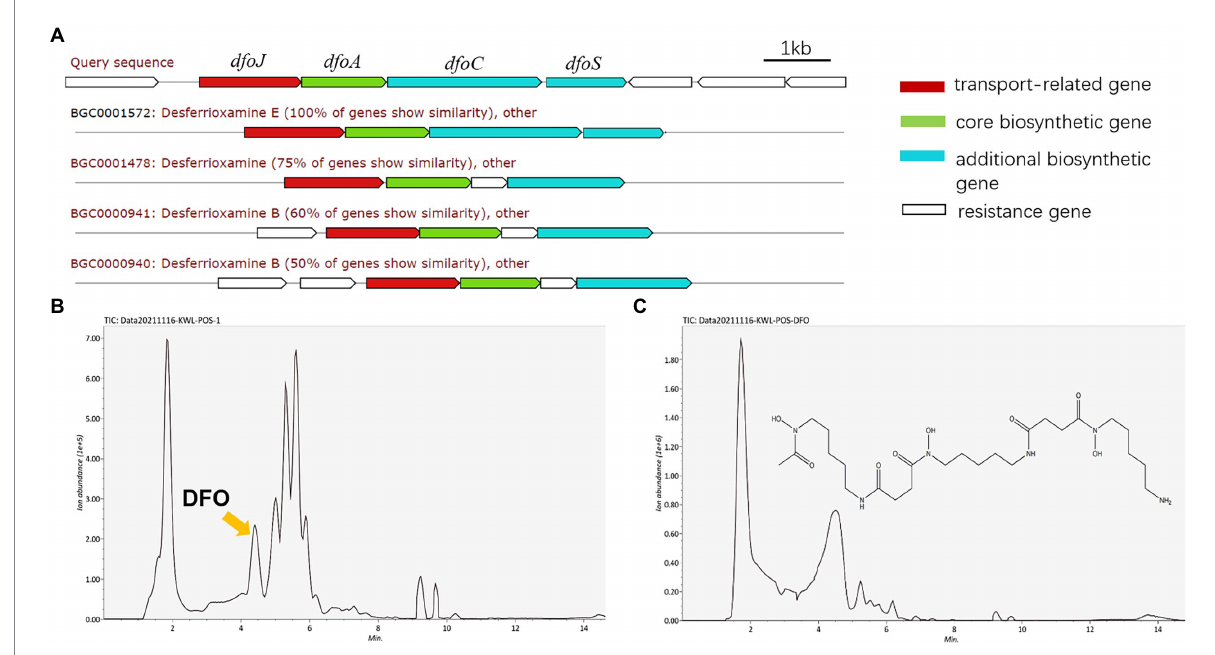
FIGURE 4 DFO, one of the predicted secondary metabolites of Rahnella aquatilis JZ-GX1. Biosynthetic gene cluster for DFO (A) , HPLC chromatogram of siderophores from JZ-GX1 culture (B) and DFO standard in the positive ion mode (C)